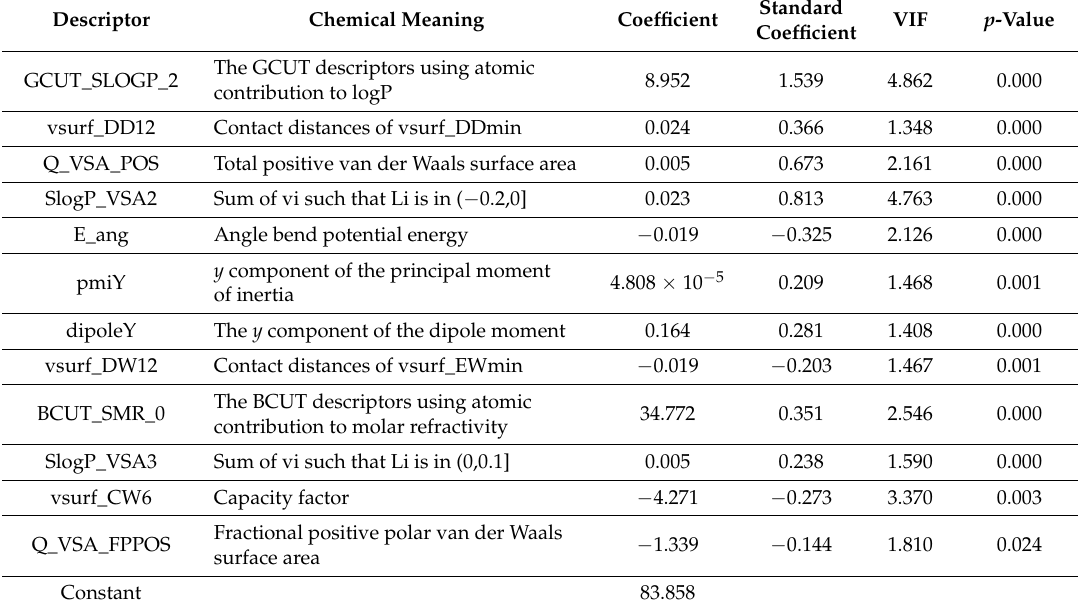
Table 3. Selected descriptors of MLR model for LXR α agonists.